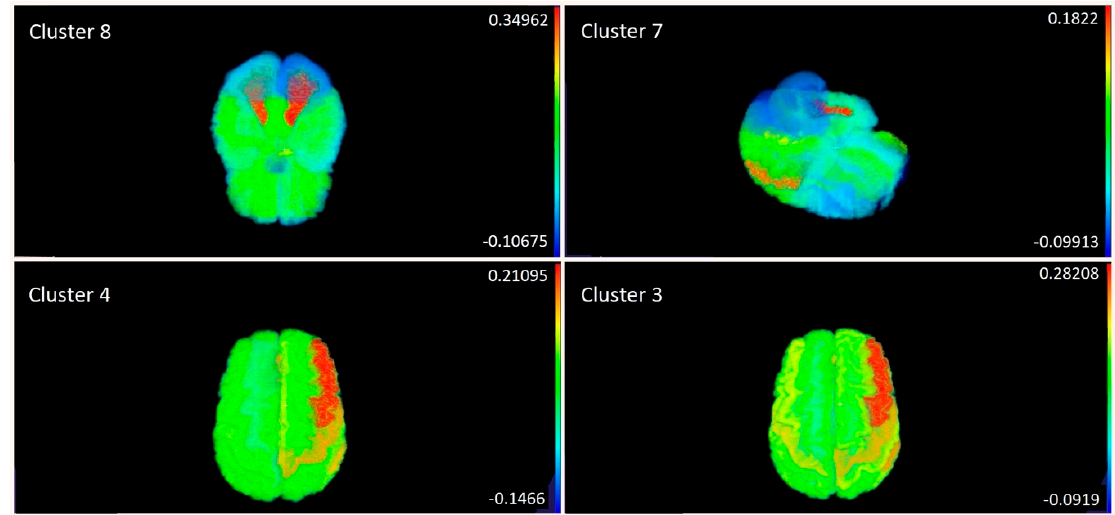
Figure 3. Correlations between four specific metabolite clusters (see Table 2) and sMRI data from different brain areas (on the scale to the left, from bottom to top: minimum to maximum).